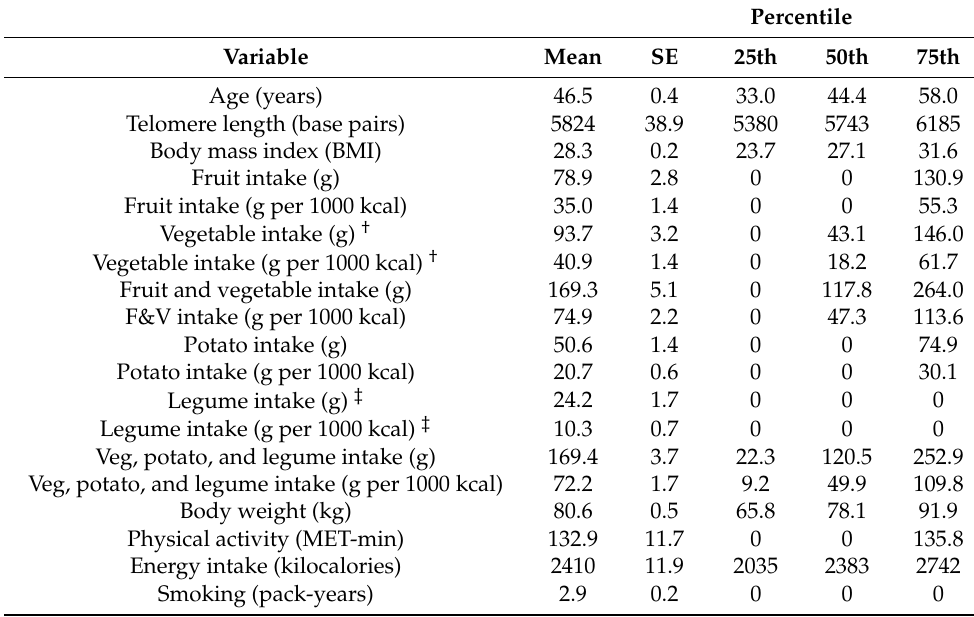
Table 1. Descriptive characteristics of the key variables in U.S. women and men ( n =